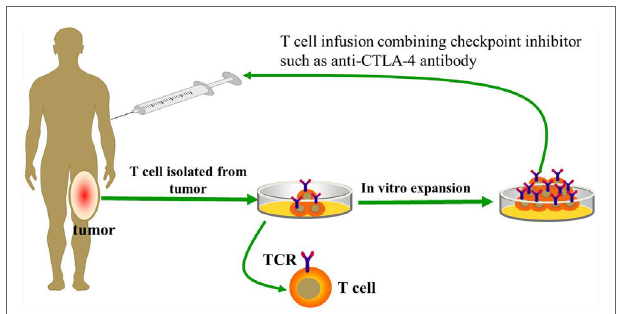
FiGURe 1 | Basic procedure of adoptive transfer T cells from tumor-infiltrating lymphocytes (TiLs)